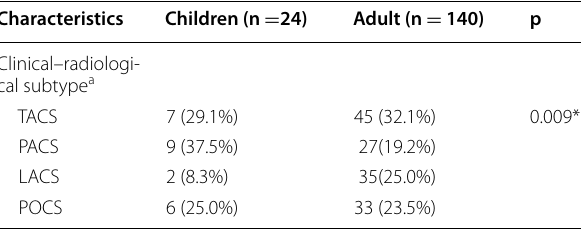
By Chi square test a No infarcts were present in some patient, *p value was significant